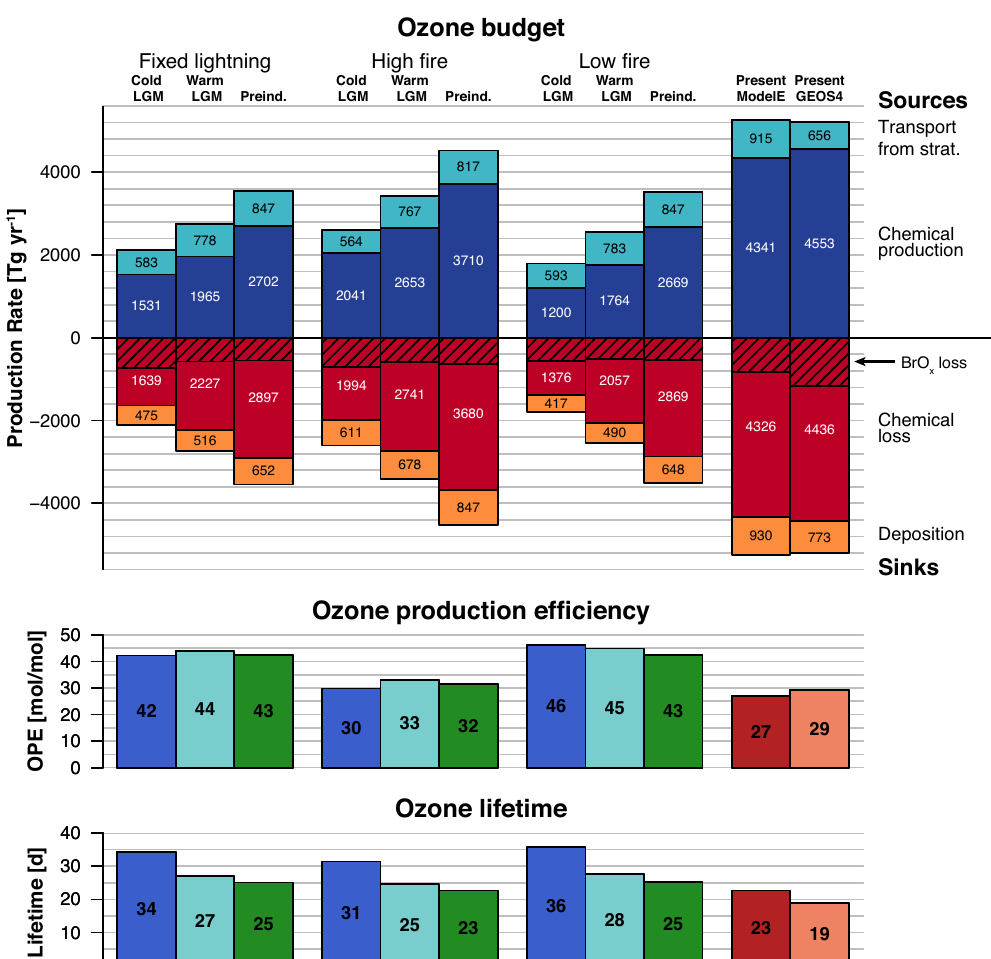
Fig. 13. Top panel: budget of tropospheric ozone in each simulation. Production and loss rates are for the odd oxygen family (O x ≡ O 3 + O + NO 2 + 2 NO 3 + organic nitrates + HNO 4 + 3 N 2 O 5 + HNO 3 + BrO + HOBr + BrNO 2 + 2 BrNO 3 ). Transport from the stratosphere is inferred by mass balance in the troposphere with chemical production, loss, and deposition. Tropopause calculated with thermal lapse rate definition. Diagonal hatching indicates net magnitude of ozone destroyed by BrO + hν → O 3 + Br and Br + O 3 → BrO + O 2 . Middle panel: O x production efficiency per unit NO x emitted. Bottom panel: lifetime of tropospheric ozone against chemical loss and deposition.